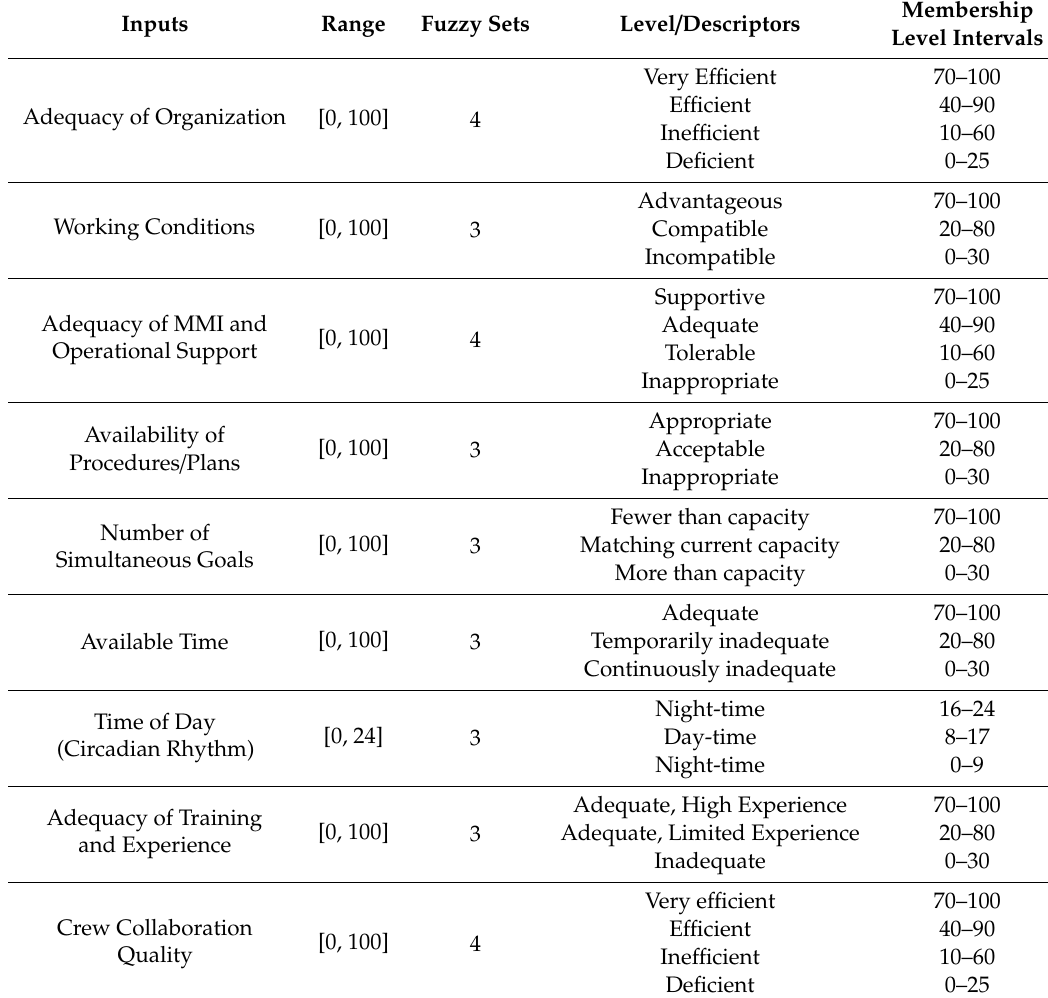
Table 1. Common performance conditions in cognitive reliability and error analysis method (CREAM) as fuzzy input